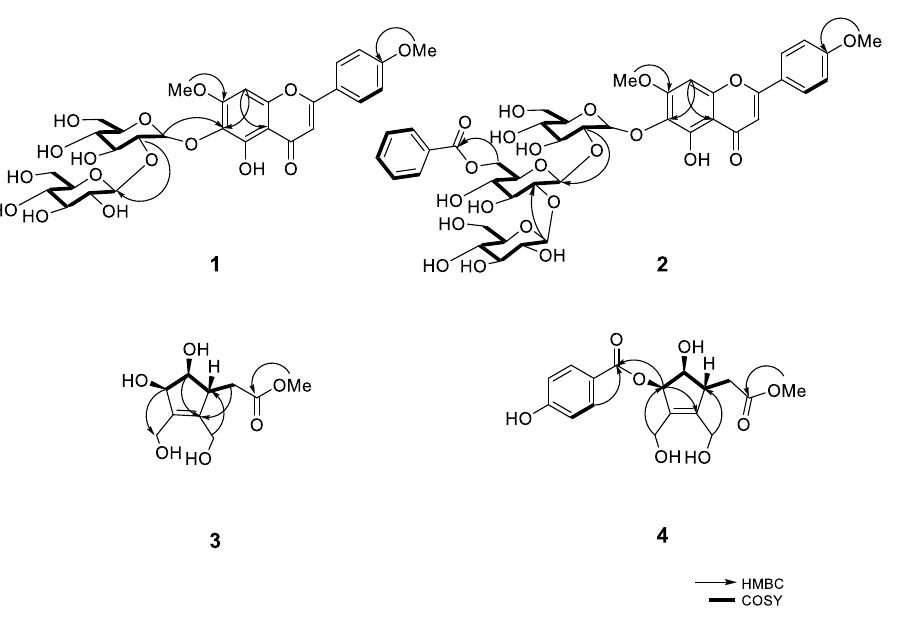
Figure 2. The key HMBC and COSY correlations of 1 − 4 .